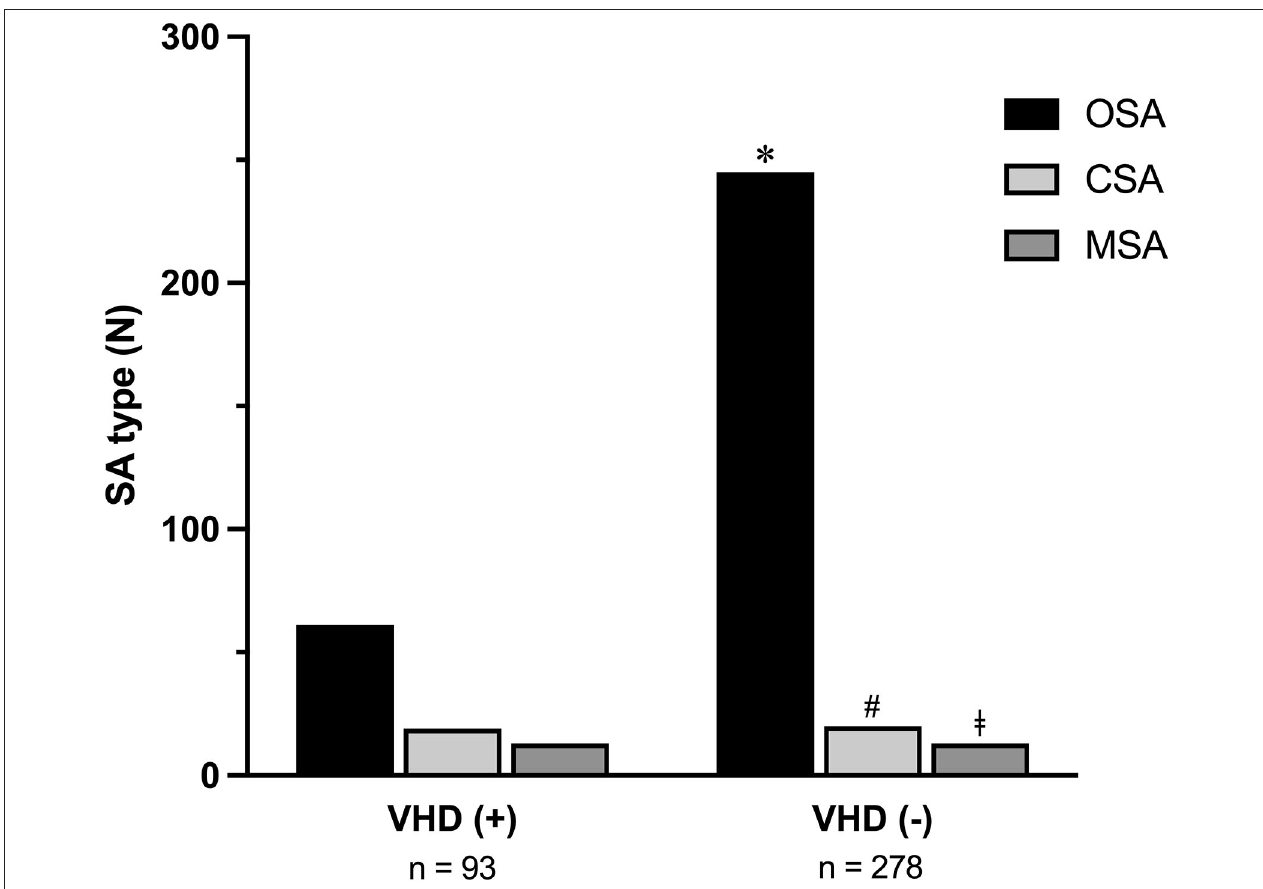
FIGURE 1 | Occurrence of OSA, CSA, and MSA in SA patients with or without VHD. OSA, obstructive sleep apnea; CSA, central sleep apnea; MSA, mixed sleep apnea; SA, sleep apnea; VHD, valvular heart disease. * p < 0.0001; # p < 0.0003; ‡ p = 0.002.